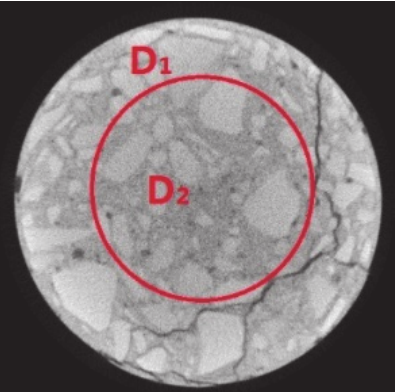
Figure 9: Concrete damage area schematic